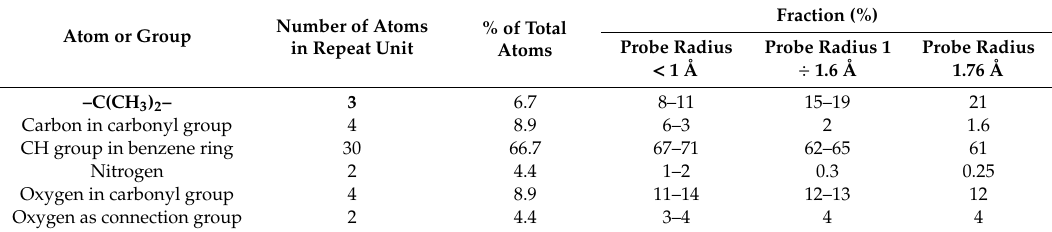
Table 5. Fraction of surface of FVEs (in %) occupied by various chemical species in Ultem as a function of the size of a probe. Hydrogen atoms, which are almost entirely within the van der Waals volume of carbon, were not considered here.